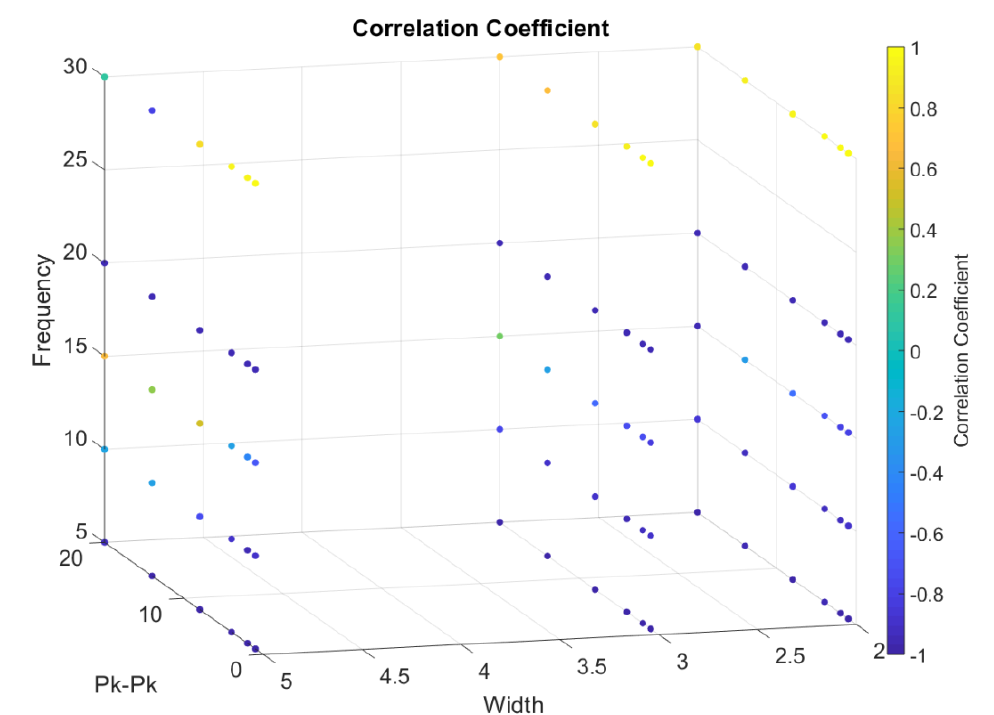
Figure 21. A 3D scatter plot for correlation